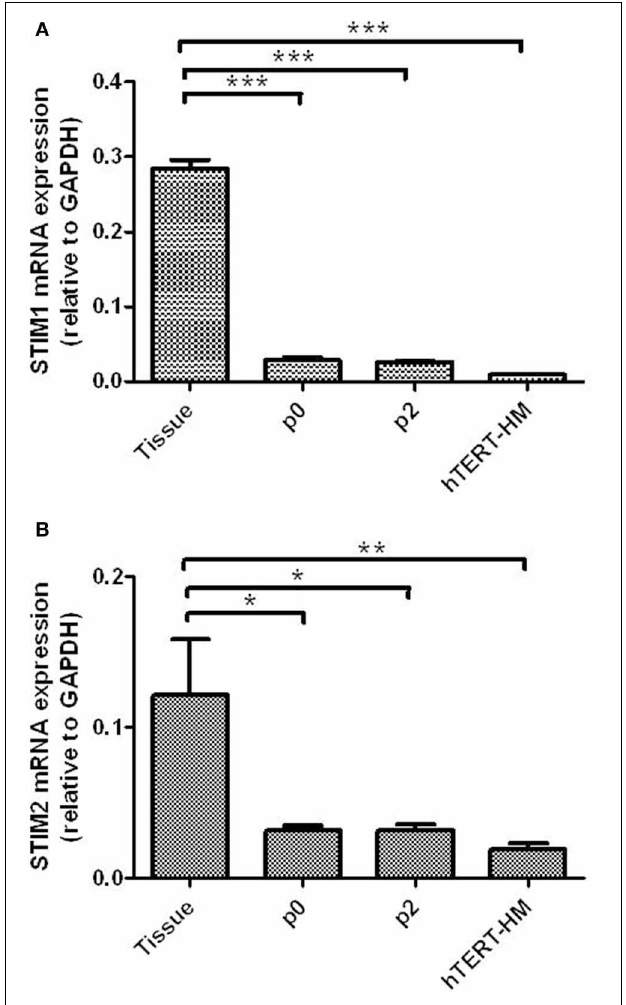
FIGURE 1 | STIM1 and STIM2 mRNA are expressed in term pregnant human myometrial tissue and cultured term pregnant (P0/P2) and non-pregnant (hTERT-HM) hUSMCs. mRNA from myometrial tissue and serum-deprived hUSMCs was extracted and assessed for (A) STIM1 and (B) STIM2 expression. Data are expressed as copy number ± s.e.m., normalized to GAPDH ( n = 6 tissues or cell cultures). ∗ P < 0 . 05; ∗∗ P < 0 . 01; ∗∗∗ P < 0 . 001 compared to tissue expression.